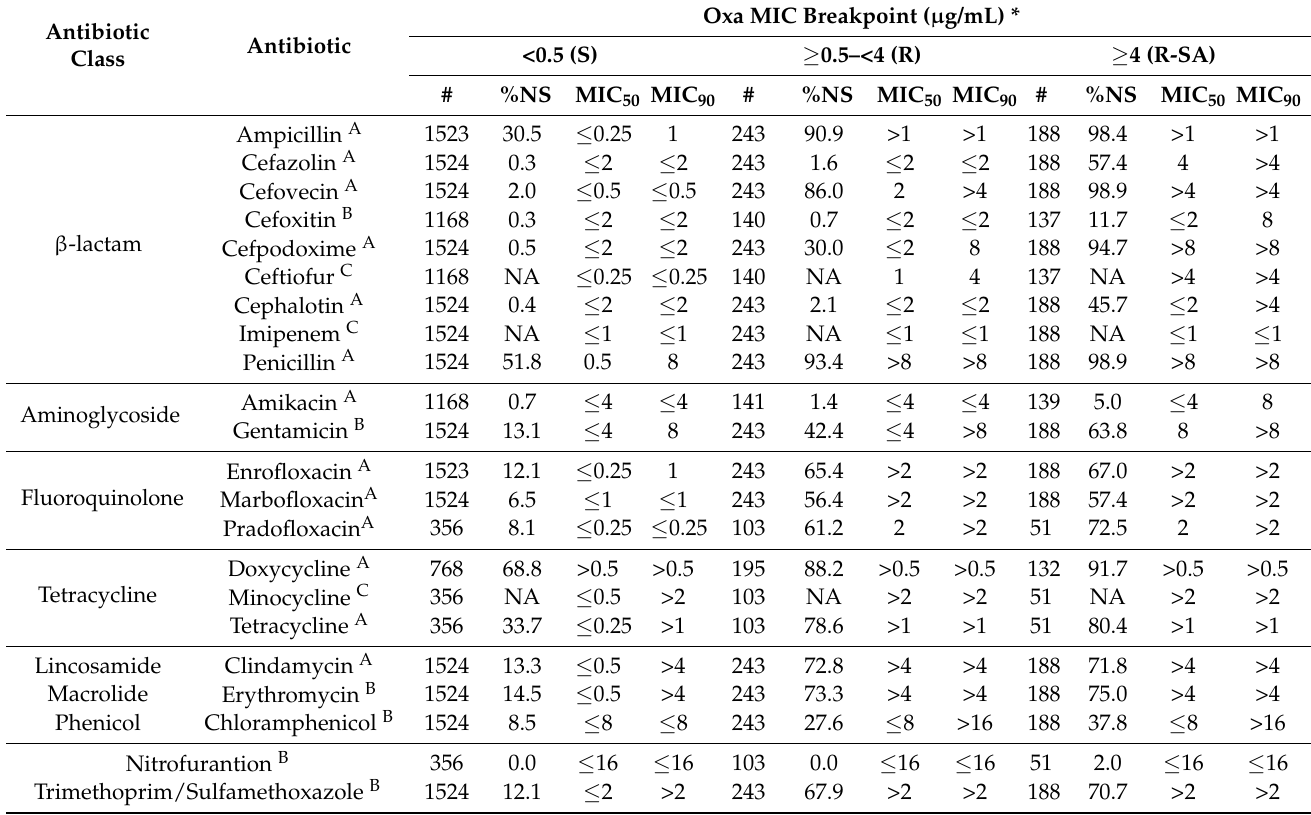
Table 1. In vitro cross-resistance patterns of S. pseudintermedius isolates by Oxacillin MIC.